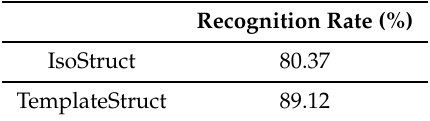
Table 10. Comparison of fingerprint classification results for the 2 proposed features vectors.